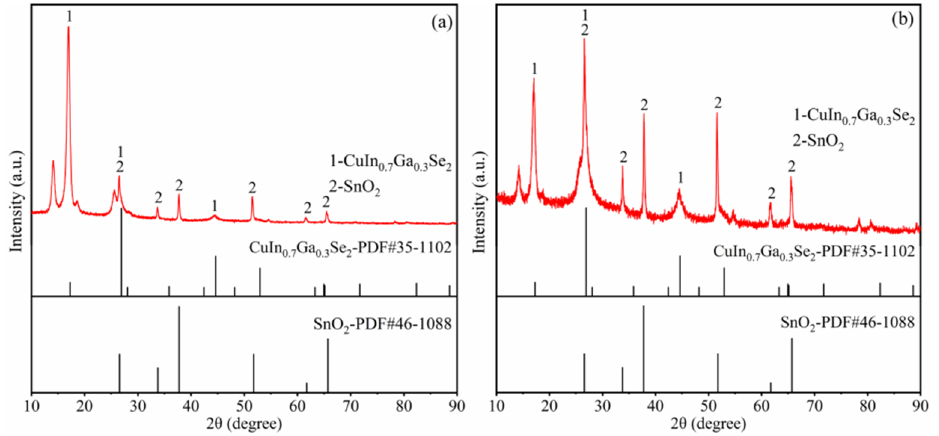
Figure 9. XRD spectra of CIGS thin film prepared at the potential of − 0.6 V and pressures of: ( a ) 80 kPa and ( b ) 3 kPa.